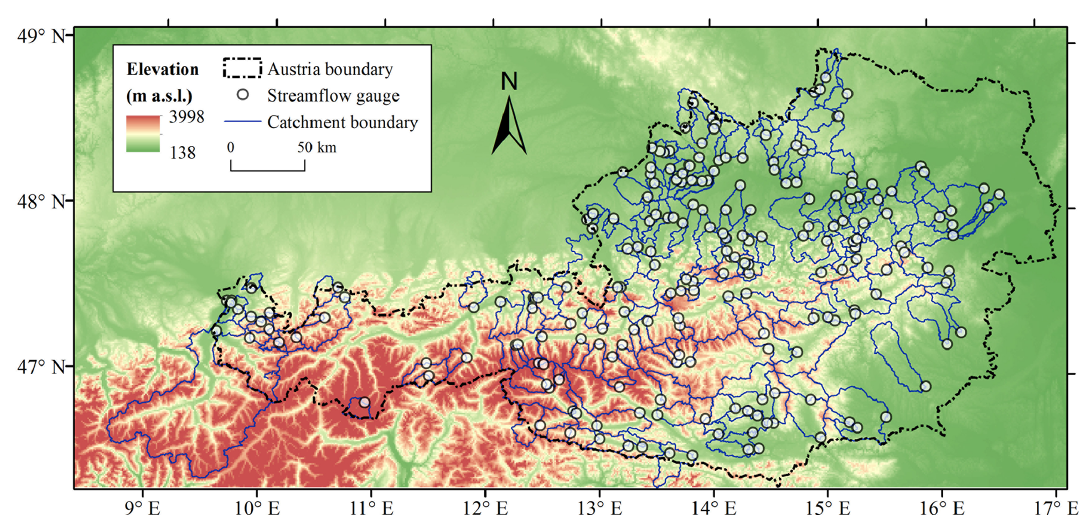
Figure 1. Topography of Austria and the location of the 213